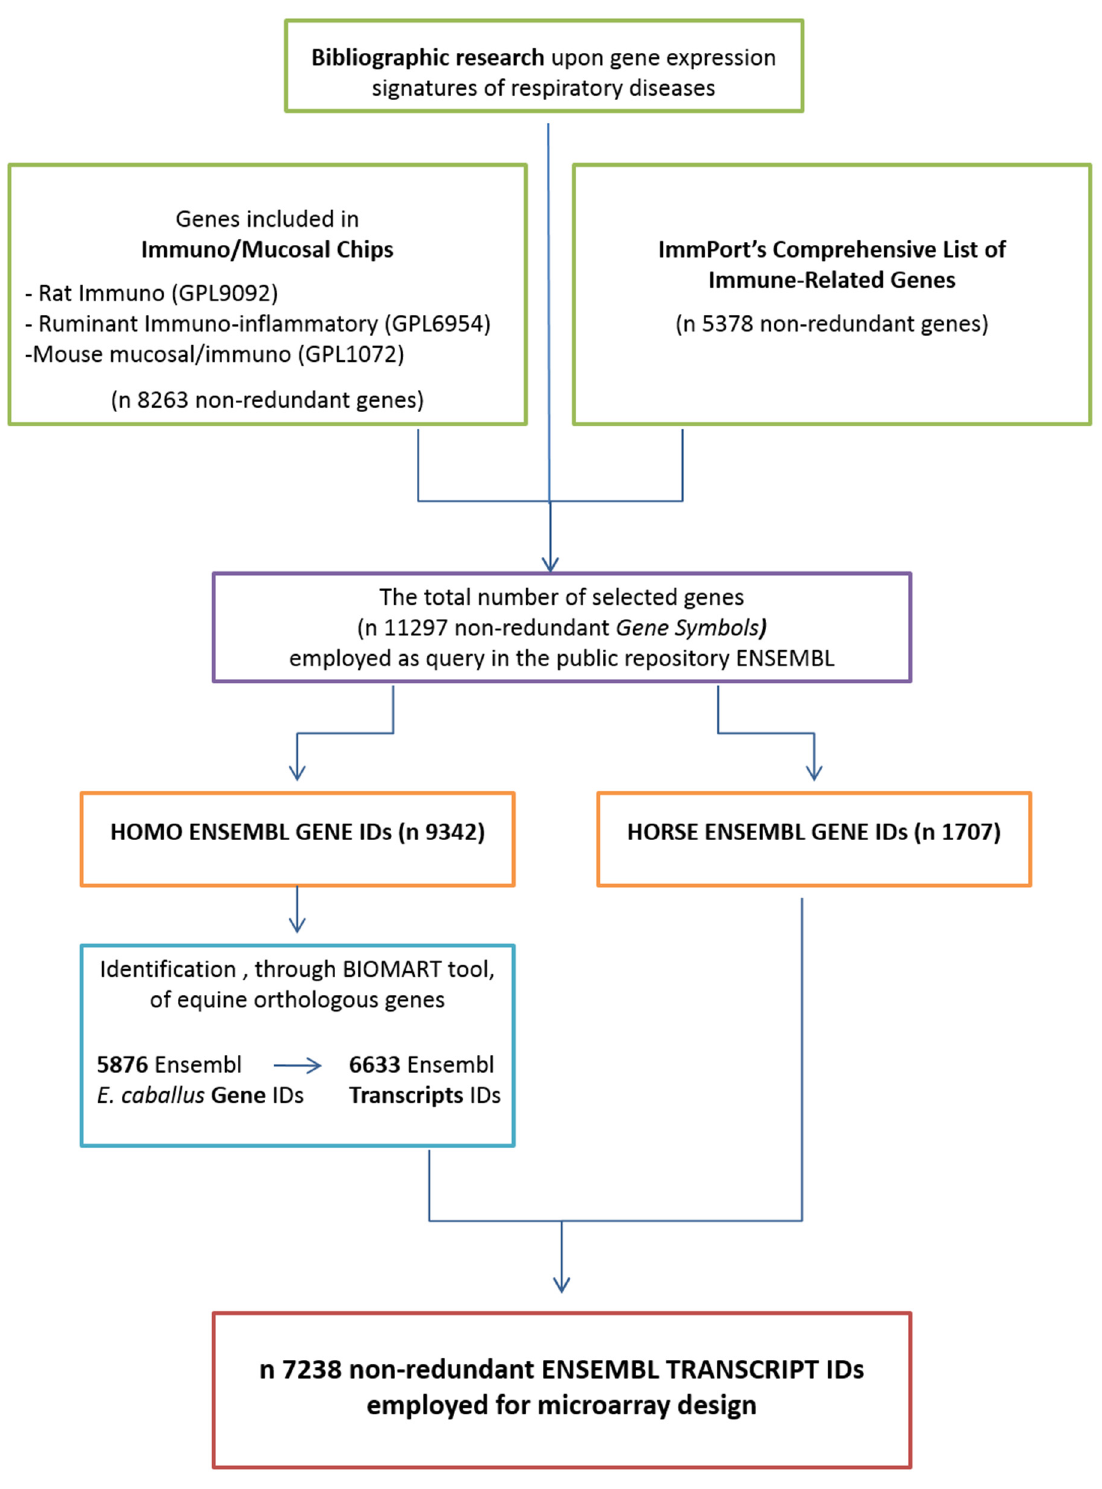
Figure 1. Microarray design. Schematic diagram of the approach used for the selection of E. caballus transcripts included in the microarray platform.